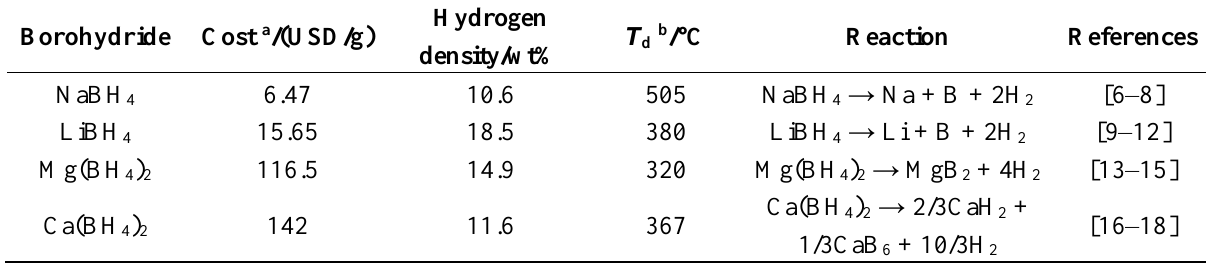
Table 1. Physical and chemical properties of